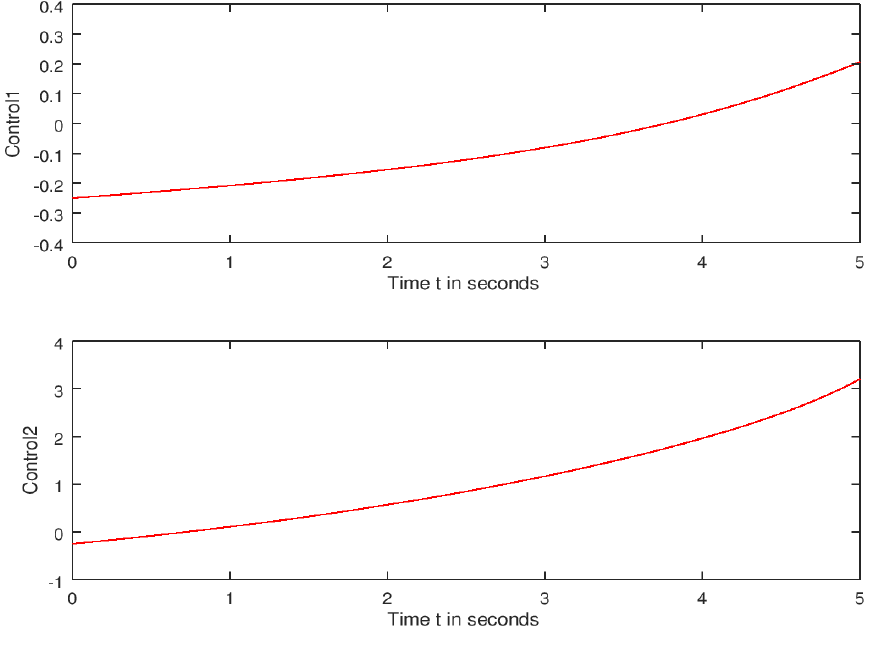
Figure 15. Feasible control strategies.